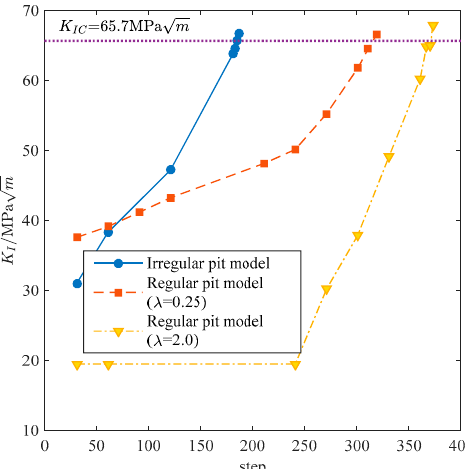
Figure19. Time-varyingcurvesofthestressintensityfactorforsteelwirewithdi ff Figure 19. Time-varying curves of the stress intensity factor for steel wire with different pit Figure 19. Time-varying curves of the stress intensity factor for steel wire with different pit Figure 19. Time-varying curves of the stress intensity factor for steel wire with different pit morphologies. morphologies. morphologies.